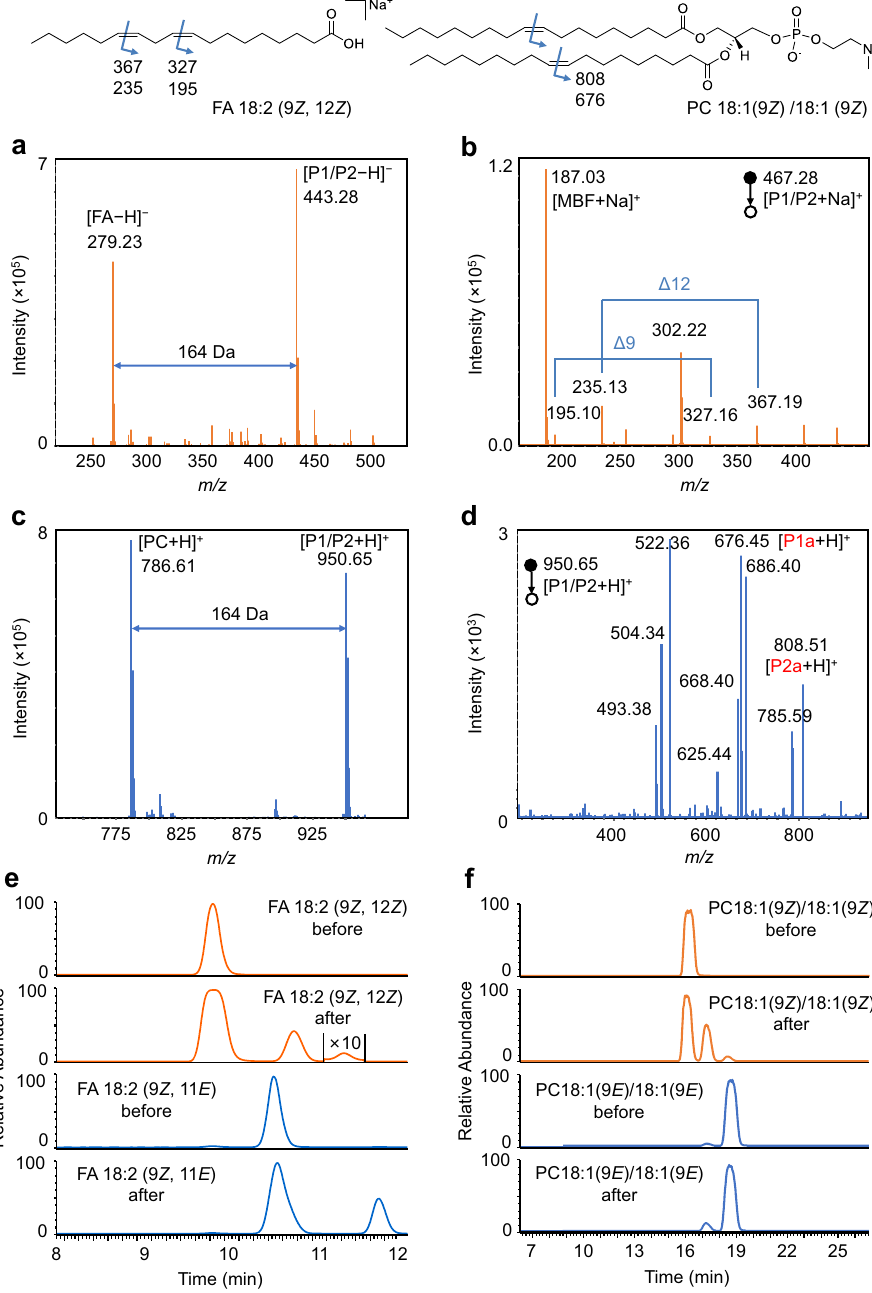
Fig. 4 Demonstration of the bifunctional reaction system for the identi fi cation of C = C bonds location and E-Z con fi guration in polyunsaturated lipids. a Mass spectrum of the photocatalytic reaction solution of FA 18:2 (9 Z , 12 Z ). b MS/MS spectrum of the sodiated photocycloaddition product (P1/P2) of FA 18:2 (9 Z , 12 Z ). c Mass spectrum of the photocatalytic reaction solution of PC 18:1 (9 Z )/18:1 (9 Z ). d MS/MS spectrum of the protonated photocycloaddition product (P1/P2) of PC 18:1 (9 Z )/18:1 (9 Z ). Assignment of the fragments: m/z 808.51, [P1a + H] + ; m/z 785.59, [PC] + ; m/z 686.40, [P1/P2 − FA 18:1] + ; m/z 676.45, [P2a + H] + ; m/z 668.40, [P1/P2 − FA 18:1 − H 2 O] + ; m/z 625.44, [P1a − C 5 H 14 NO 4 P (183)] + ; m/z 522.36, [PC − FA 18:1] + ; m/z 504.34, [PC − FA 18:1 − H 2 O] + ; m/z 451.34, [P2a − C 5 H 14 NO 4 P (183)] + . e EICs of FA 18:2 (9 Z , 12 Z ) and FA 18:2 (9 Z , 11 E ) before and after the photocatalytic reaction at m/z 279.2 in negative ion mode. f EICs of PC 18:1 (9 Z )/18:1 (9 Z ) and PC 18:0/18:2 (9 Z , 12 Z ) before and after the photocatalytic reaction at m/z 786.6 in positive ion